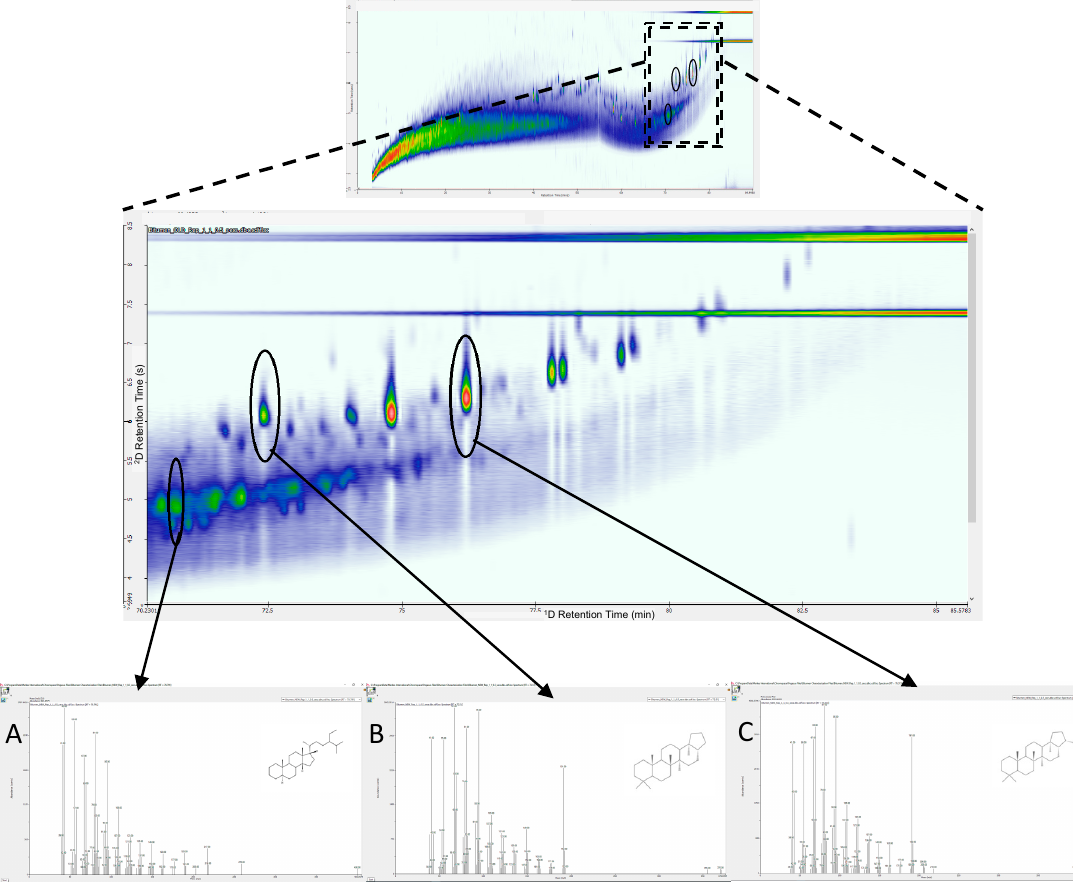
Figure 5. Tentative identification of three characteristic biomarkers in the biomarker region of the cyclohexane extract. The compounds ( A ) 24-ethyl-5 α (H)-14 β (H), 17 β (H)-20R-cholestane (C 29 αββ -20) ( B ) 17 α (H)-22,29,30-trisnorhopane (T m ), and ( C ) 17 α (H)-21 β (H)-hopane (H30) were identified by EIC and molecular ion peak.